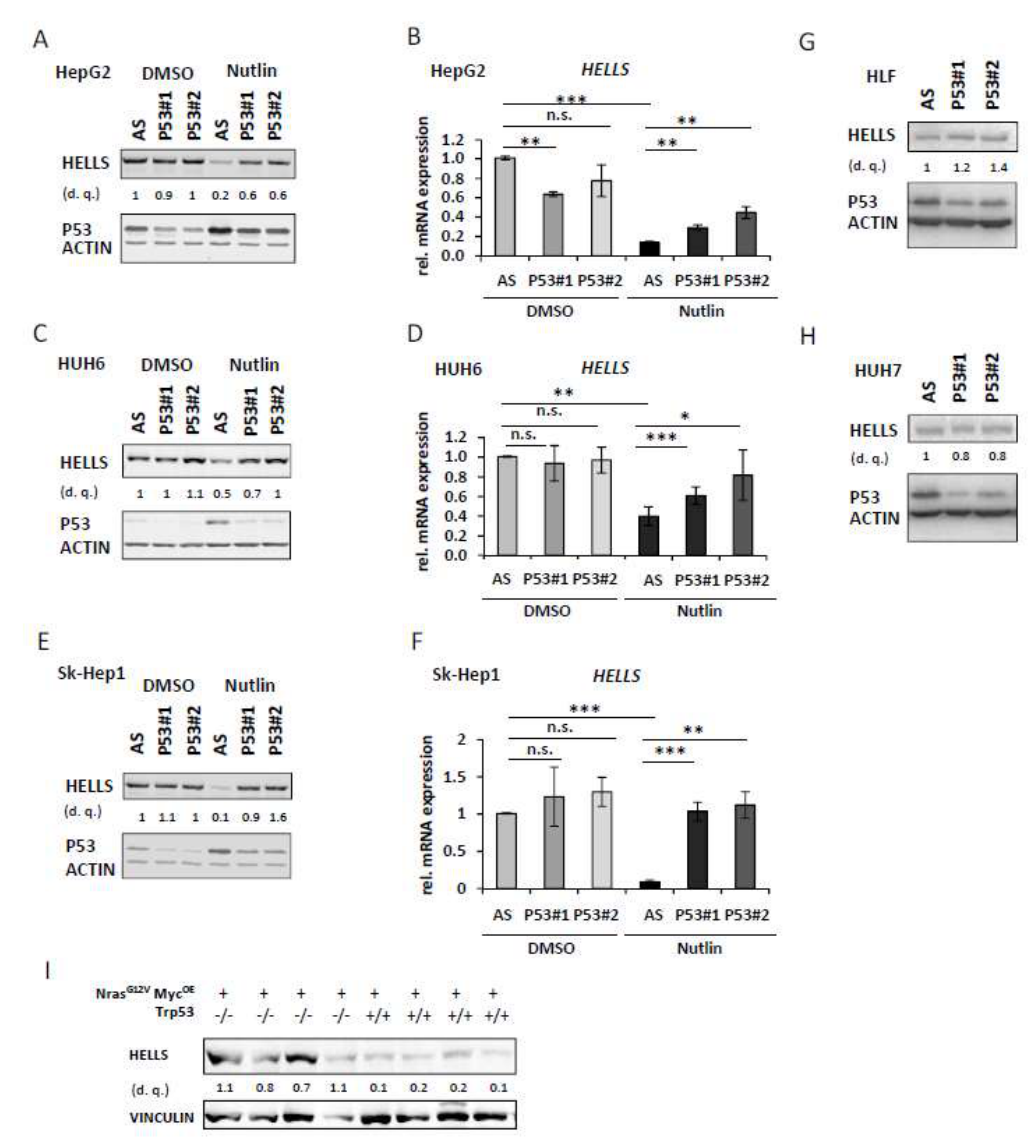
Figure S3 highlights well known P53 activation (e.g., MDM2 , CDKN1A and TIGAR ) and repression (e.g., CDC25C , CCNB1 and PLK1 ) targets [31] as a plausibility check of the data set.